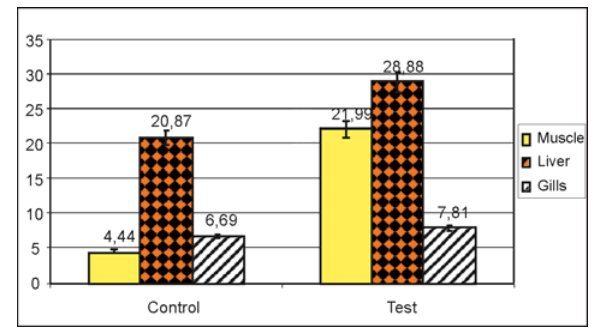
Fig. 14. Zinc concentration (mg/kg) in tissues of stone